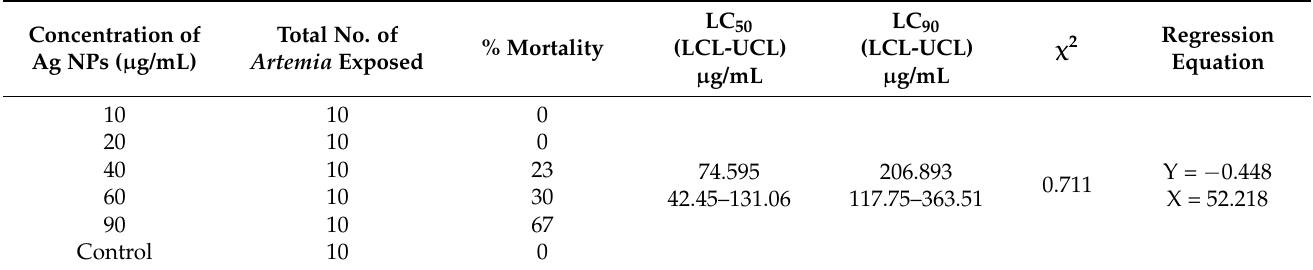
Table 6. Toxicity assay of Priestia aryabhattai -mediated Ag NPs on Artemia nauplii . Concentration of Ag NPs ( µ